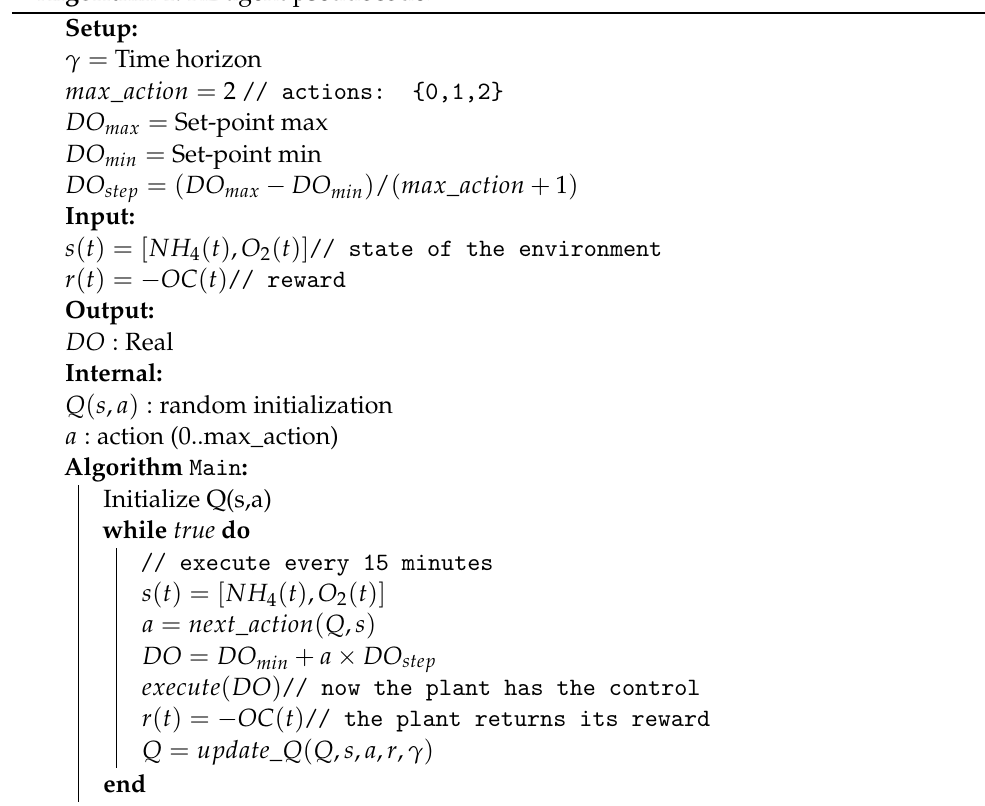
Algorithm 1: RL agent